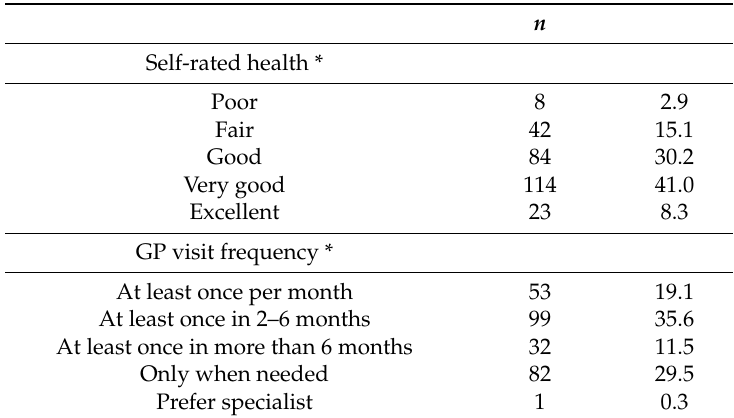
Table 2. Self-reported hypertension status and BP-lowering medications.